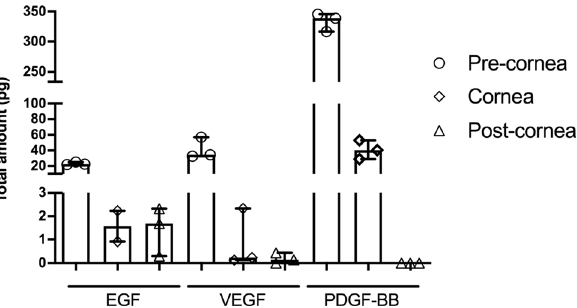
Figure 3. Bioavailability on different compartments on an ex vivo porcine corneal model. Results of ex-vivo permeation study showing the total amount (in pg) of three proteins: EGF, VEGF and PDGF-BB found in the 3 compartments: pre-corneal, corneal and post-corneal after application of CBED for 5 h in this model. Bars show the median and